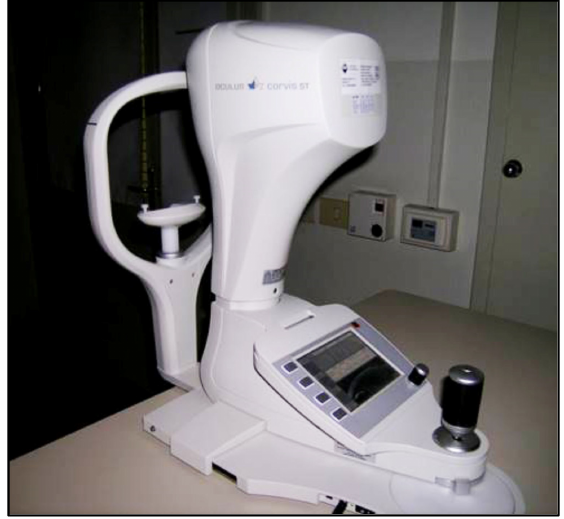
Figure 8. Corvis